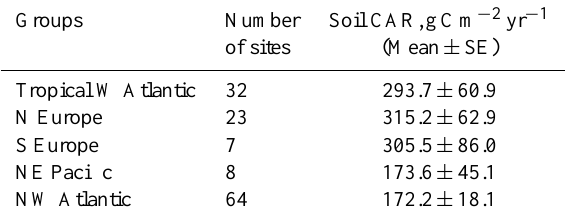
Table 3. Comparison of CAR among salt marsh geographic groups. Australasia, Sino-Japan and Arctic are excluded from the analysis due to low number of sites. Southern Europe includes the north- ern Mediterranean sites and Portugal. There are no significant dif- ferences in the mean CAR value among the five groups for which sufficient data are available for comparison (Kruskal–Wallis test, P > 0 . 05).